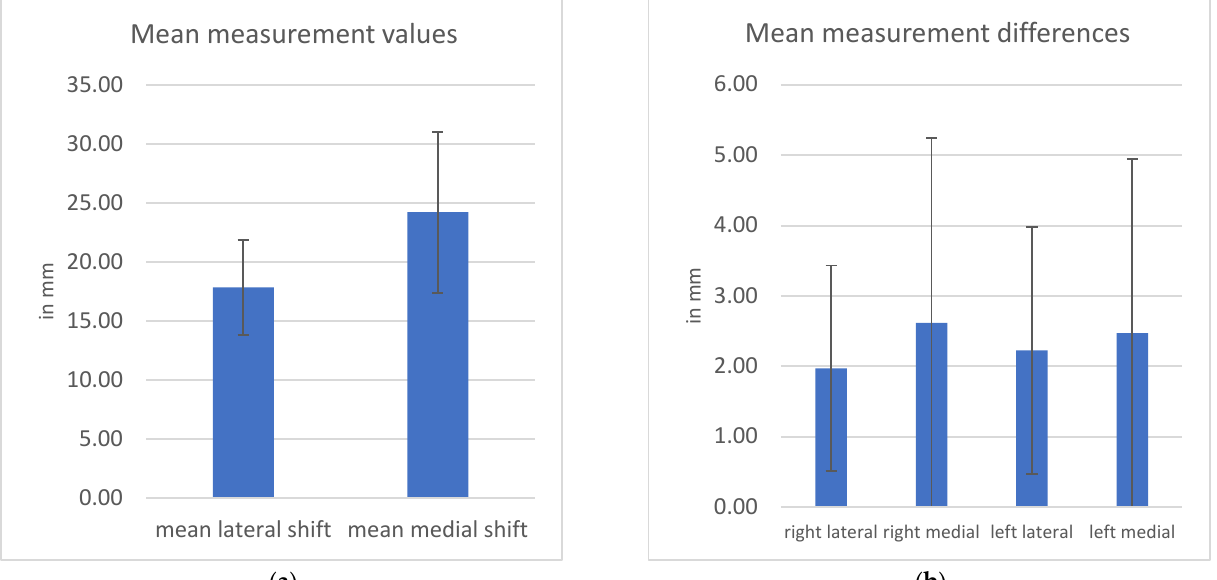
Figure 3. ( a ) Mean values of all measurements with standard deviation as measurement error; ( b ) mean values of differences between measurements with standard deviation as measurement error. The mean differences between the patellar mobility were, respectively: 1.97 ± 1.46 mm for right lateral displacement, 2.62 ± 2.63 mm for right medial displacement, 2.23 ± 1.76 mm for left lateral displacement and 2.47 ± 2.47 mm for left medial displacement (Figure 3b). The mean absolute deviation of all measurements was 1.49 ± 2.03 mm. The test–retest reliability correlation coefficients were r = 0.81, ICC(2,1) or Cronbachs Alpha = 0.89 for lateral patella displacement and r = 0.86, ICC(2,1) or Cronbachs Alpha = 0.93 for